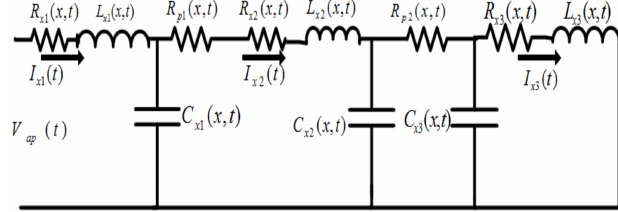
Figure 13. Electrical equivalent circuit of three dry bands